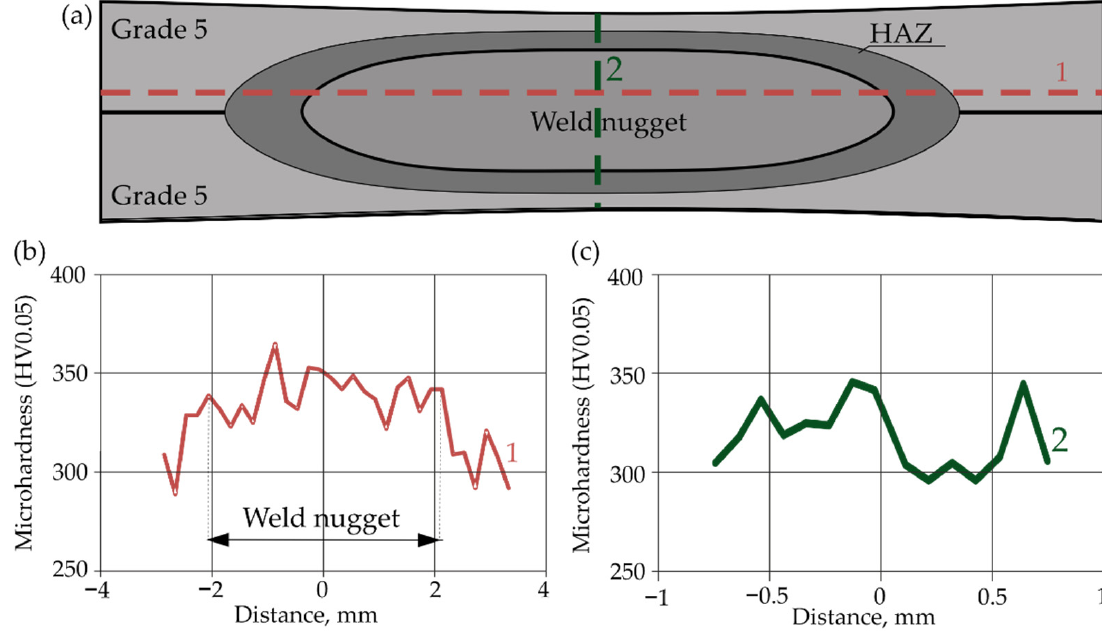
Figure 15. Microhardness Gr5–Gr5 joints: ( a ) horizontal and vertical measurement lines; ( b ) horizontal hardness distributions and ( c ) vertical hardness distribution.